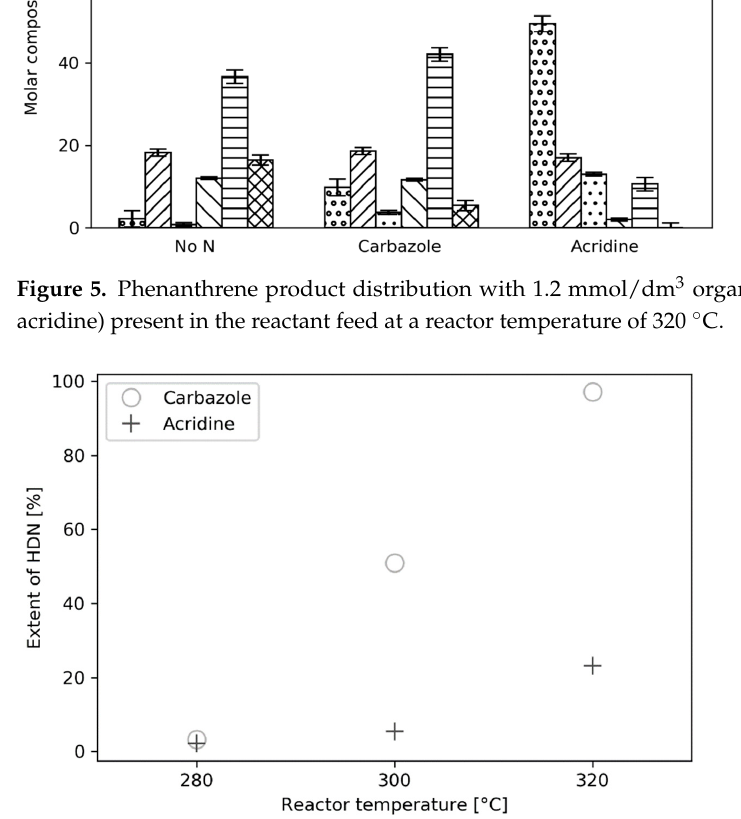
Figure 6. Extent of nitrogen removal, HDN, for carbazole and acridine at different reactor tempera- tures at a concentration of 1.2 mmol/dm 3 . Error bars not shown in the figure; however, they are approx. ±2%.